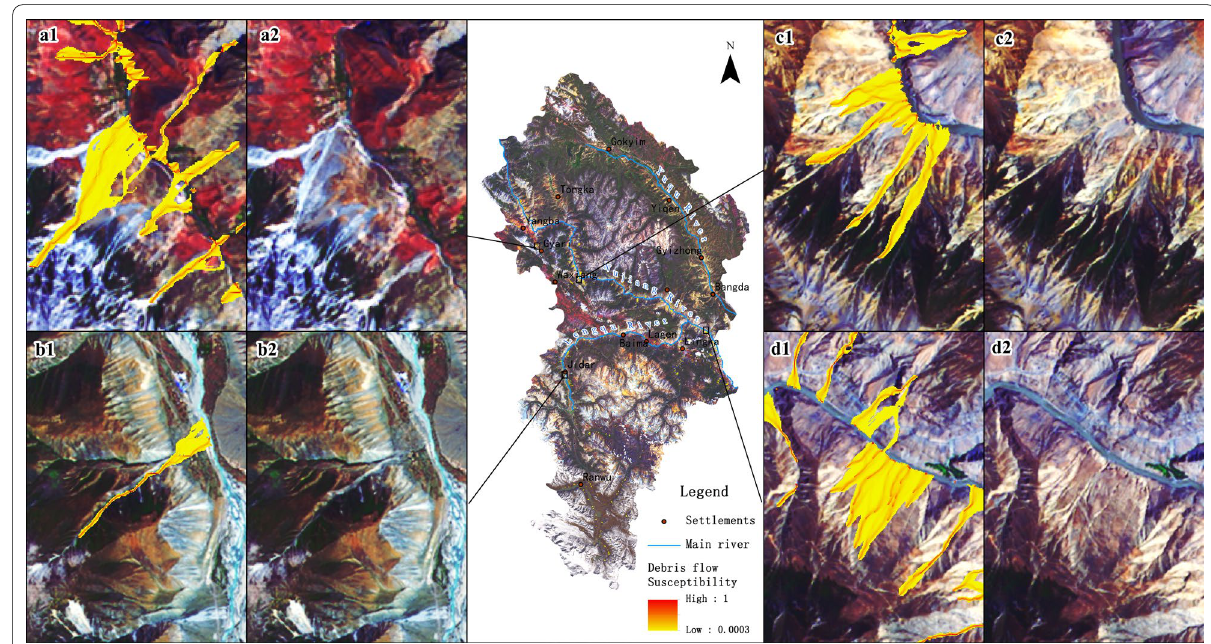
Fig. 6 Random partial validation using Landsat-8 OLI_TIRS images. a1 , b1 , c1 , and d1 represent the susceptibility results of debris flow superimposed on four remote sensing images; a2 , b2 , c2 , and d2 represent base maps of remote sensing